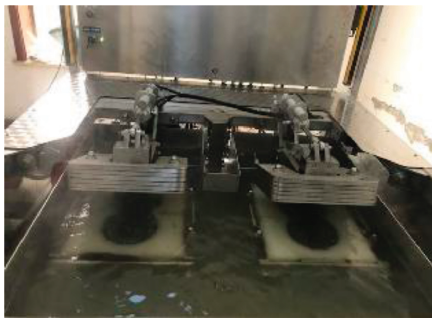
Figure 7: Hamburg wheel tracking device.